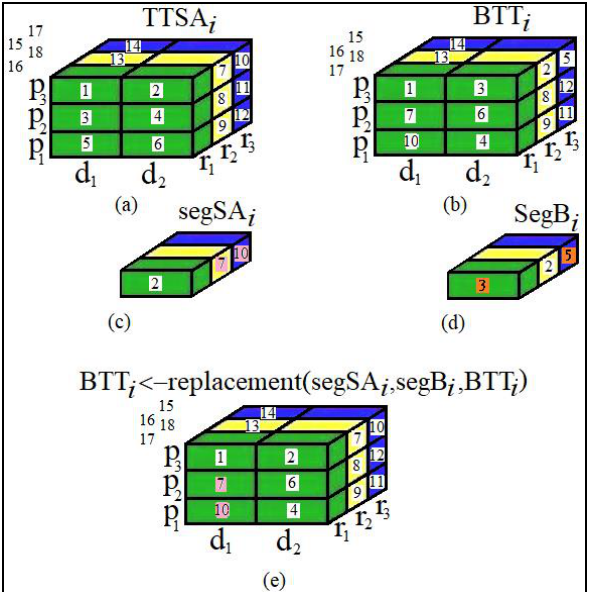
Figure 4. Processes cooperation between a pair of solutions, the best obtained by a process vs. the best of all processes (TTSA i vs. BTT i ). ( a ) Best solution obtained by process i, TTSA i . ( b ) Best solution of all processes, BTT i . ( c ) TTSA i segment to insert into BTT i . ( d ) BTT i segment to be replaced from BTT i . ( e ) New BTT i solution with a lower d-Hamming value with TTSA i that requires a correction to make it feasible (procedure